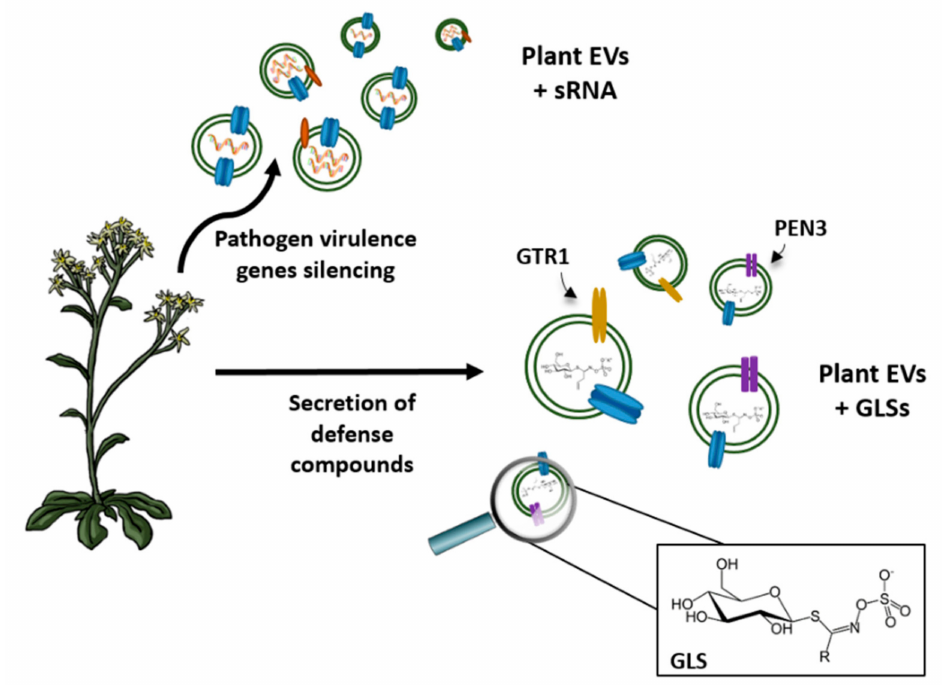
Figure 1. Against a pathogen attack, plants secrete extracellular vesicles (EVs) as a defense response. As seen above, plant EVs can contain small RNA (sRNA) that can silence virulence genes present in the pathogen. Another strategy is to secrete defense compounds, such as glucosinolates (GLSs), and include transport-related proteins, such as GTR1 (glucosinolate transporter-1) and PEN3 (an ATP-binding cassette transporter), in their